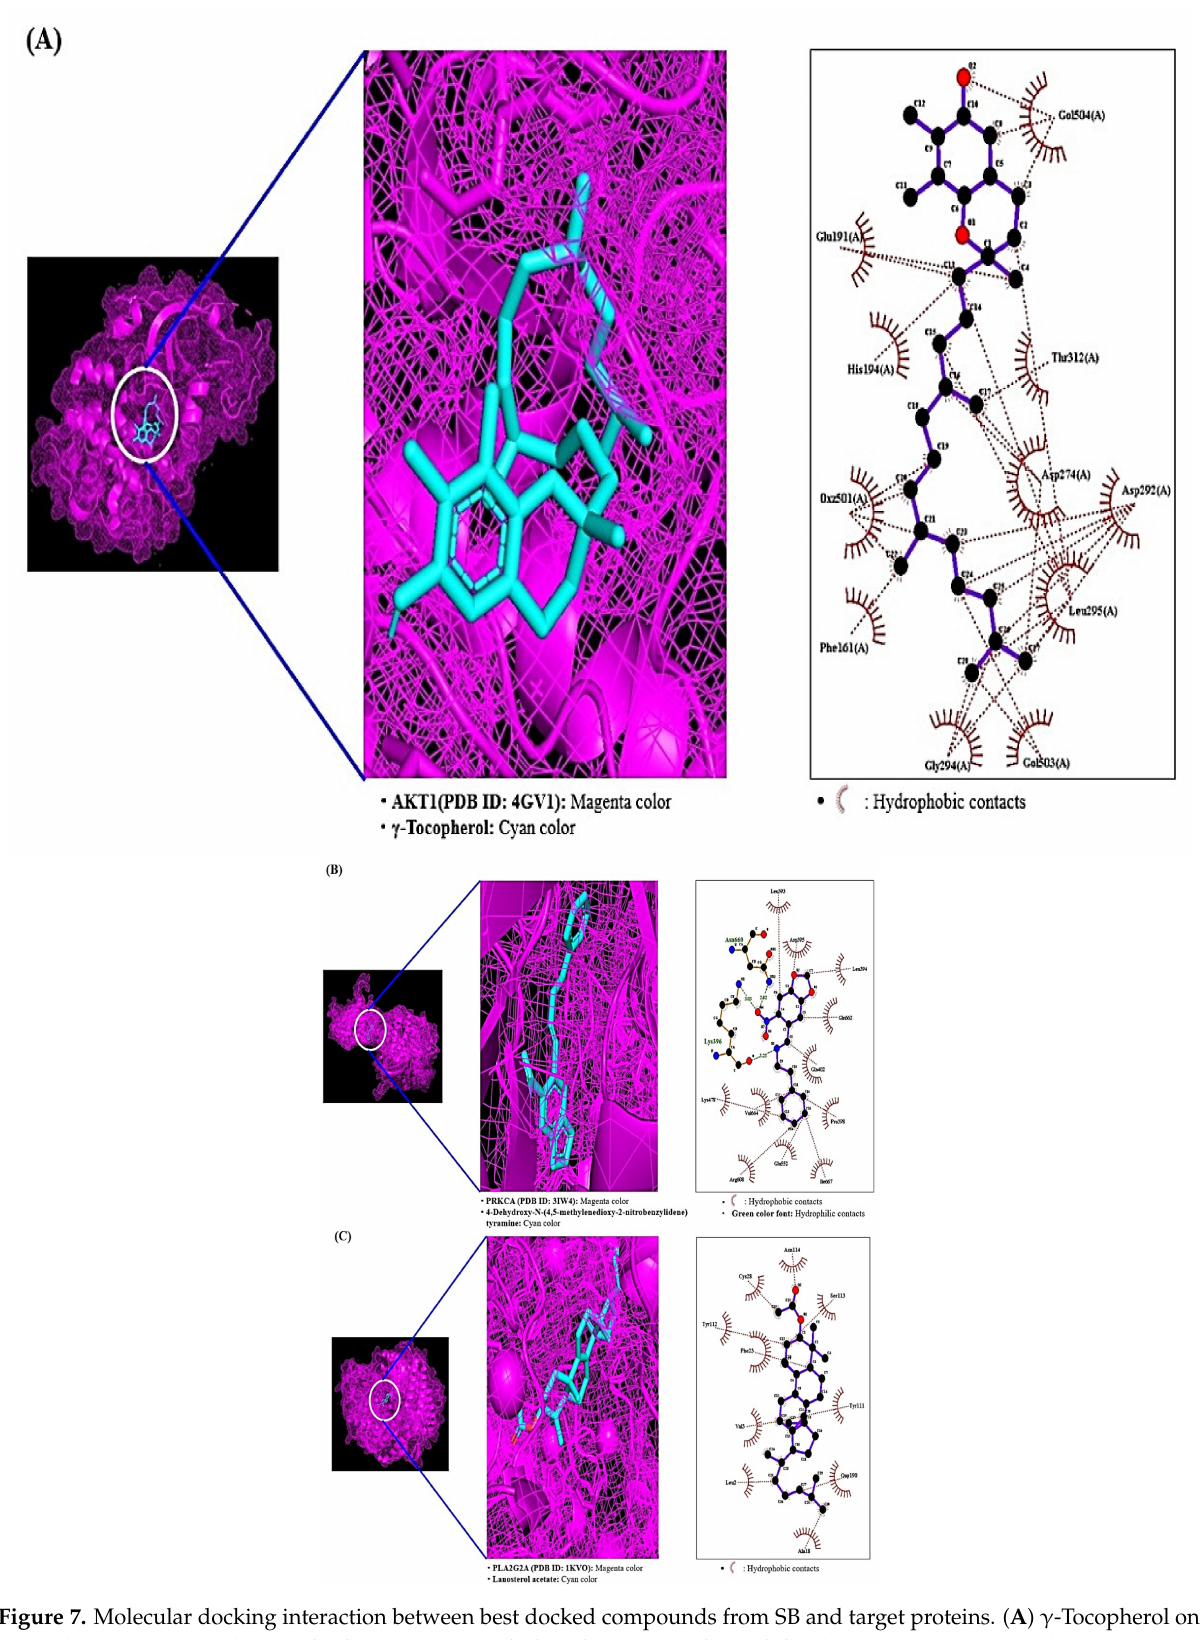
Figure 7. Molecular docking interaction between best docked compounds from SB and target proteins. ( A ) γ -Tocopherol on ( C ) Lanosterol acetate on PLA2G2A (PDB ID: